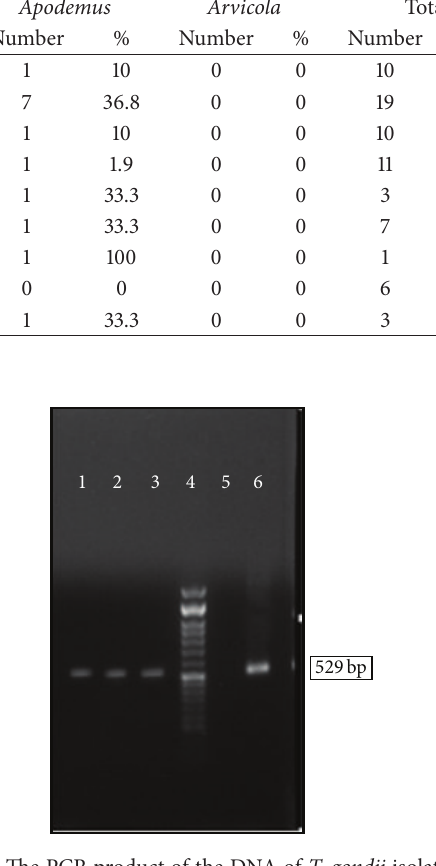
Figure 3: The PCR product of the DNA of T. gondii isolated from the rodents brain tissues. Lanes 1–3, samples isolated from rodents’ brain tissue; lane 4, 50bp DNA Ladder; lane 5, negative control; lane 6, positive control (tachyzoite prepared from mice